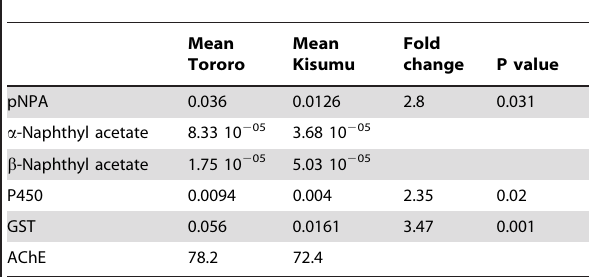
Table 3. Comparisons of average values for a range of biochemical assays between F 1 adult progeny An. funestus from Tororo populations and the An. gambiae Kisumu insecticide-susceptible reference